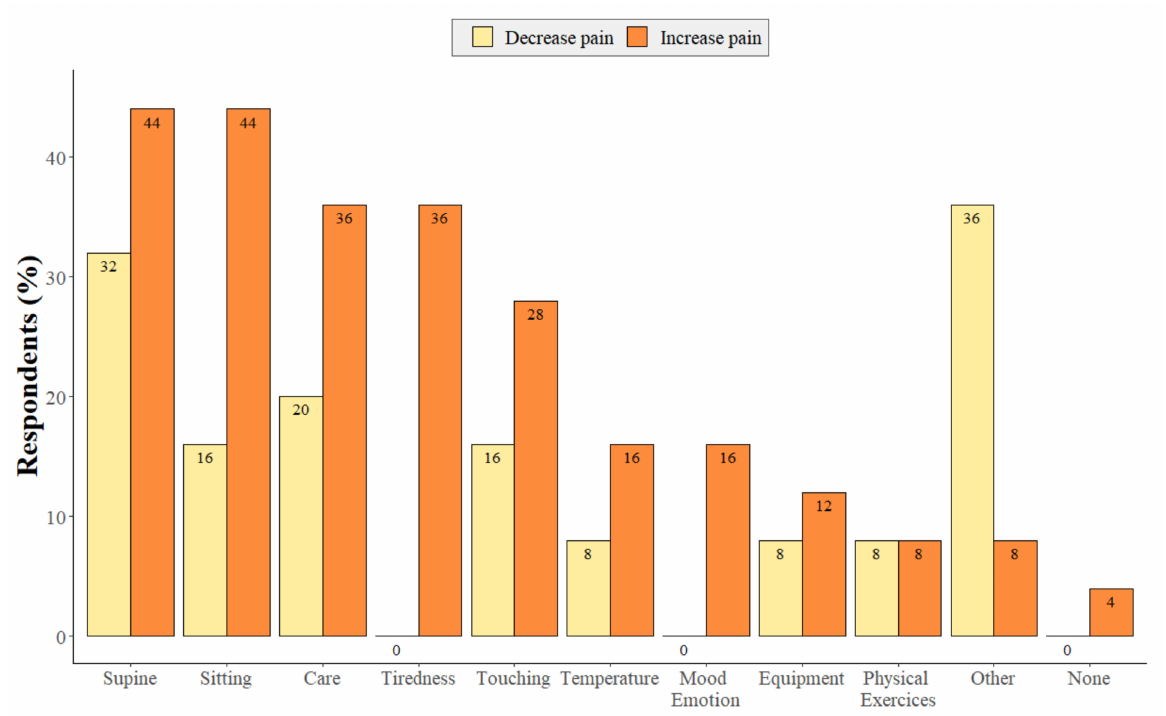
Figure 3. Distribution of the different elements that can increase (in orange) or decrease (in yellow) pain in LIS patients (multiple select answer). (Other = feeding, daily handling increase pain, Botox injection, use of medication decreases